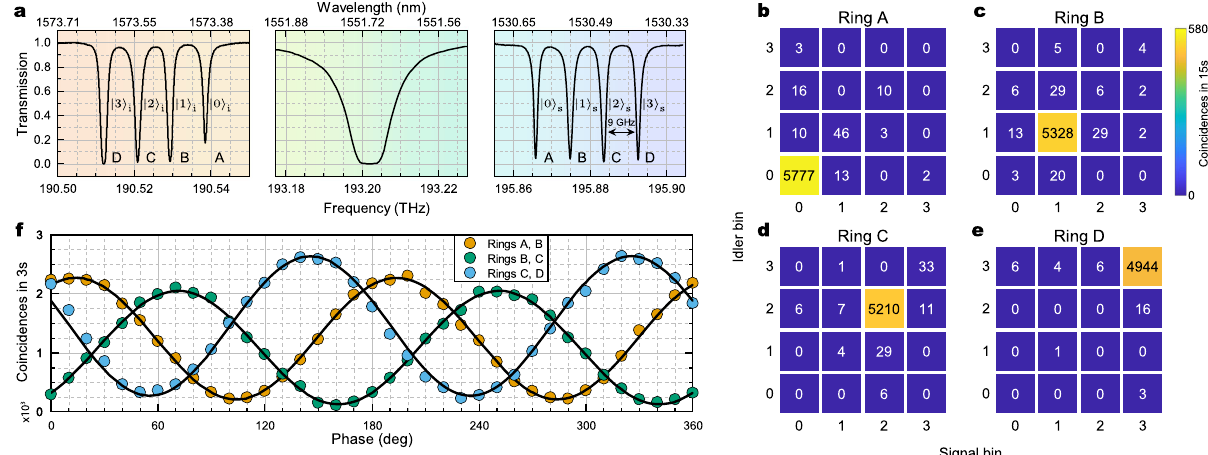
Fig. 7 | Higher-dimensional states ( qudits ). a Normalized transmission spectrum of the device used for the generation of higher-dimensional states. The device layoutisanalogoustotheoneshowninFig.1a,butfourgenerationrings(labeledA, B, C, D) are involved. Panels from left to right show respectively the idler, pump, and signal resonances associated with the correspondent four rings involved.